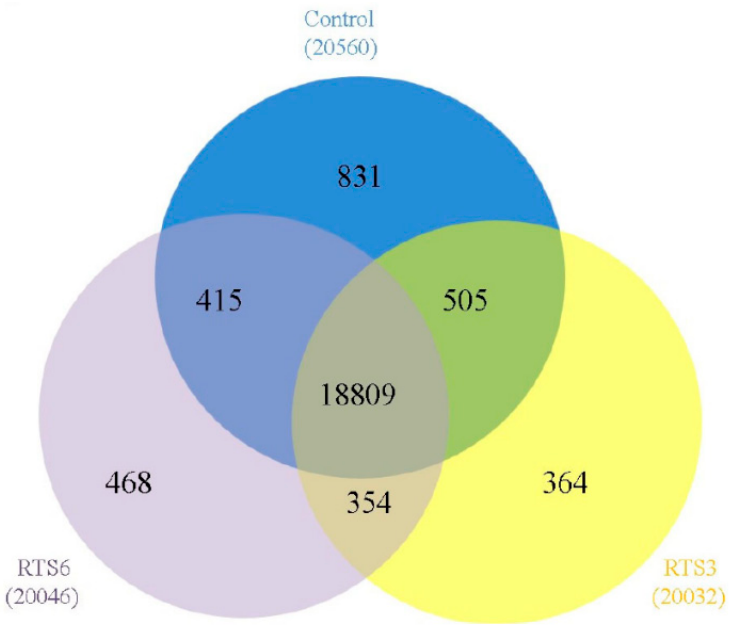
Figure 6. Venn diagram of transcripts in pomegranate pericarp. Control, RTS3 and RTS6 represent the pericarp of fruit stored for 0, 3 and 6 d.